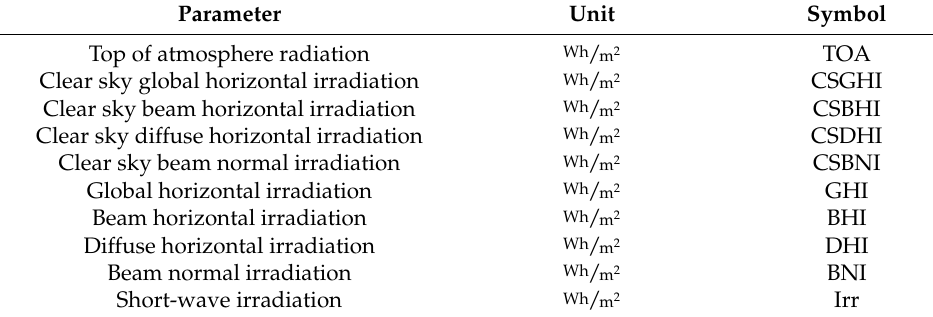
Table 1. Solar irradiation parameters.